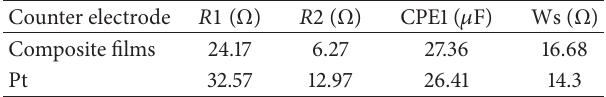
Table 2: I-V parameters of these cells in Figure 8. Counter electrode Composite electrode